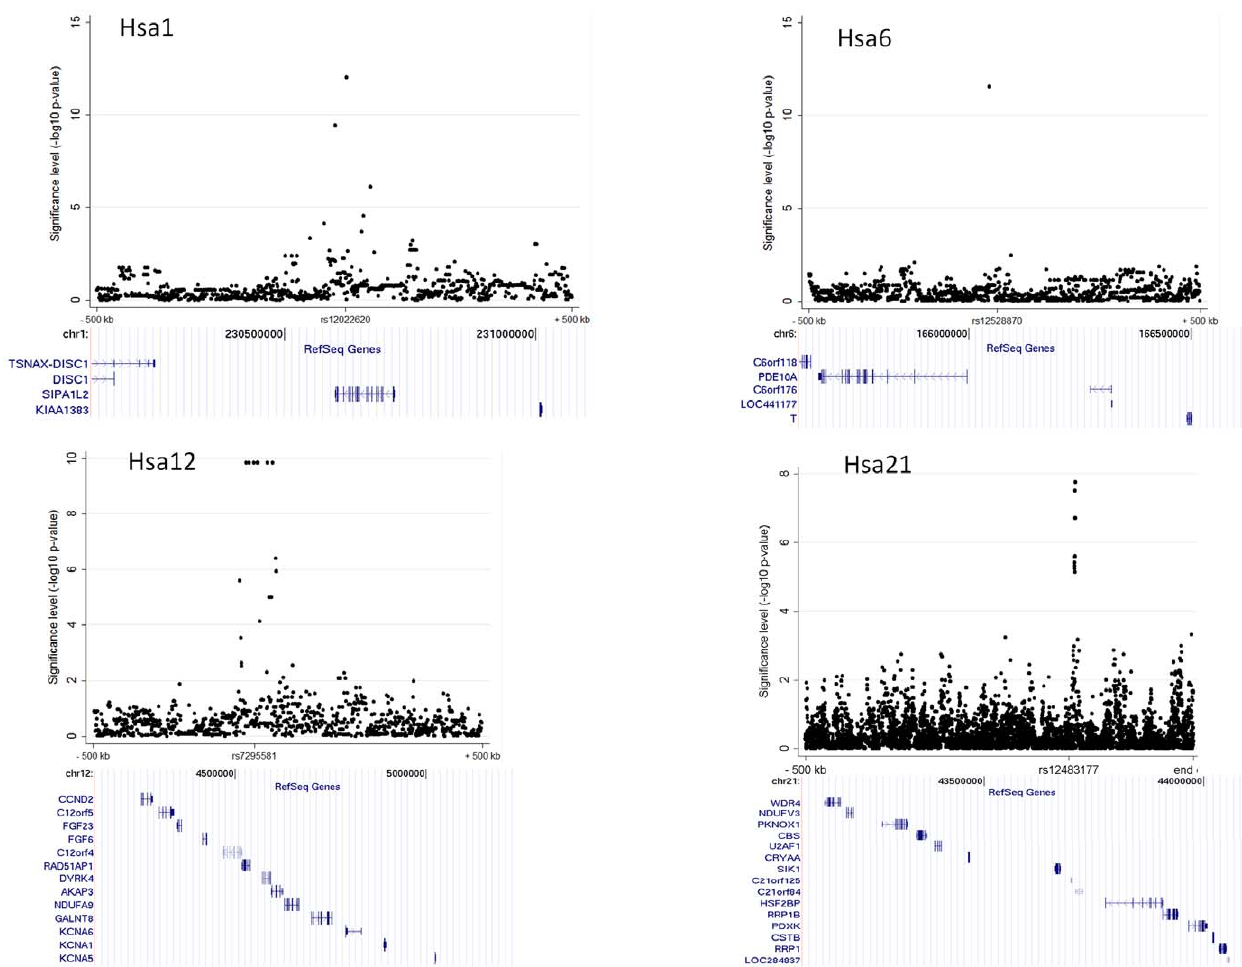
Figure 5. Examples of significant association findings in HapMap GWA. The significance level ( 2 log 10 P) of the top two association findings and two examples of top hits overlapping with either linkage, top GWA in KORA-GenCord, overlap with known candidate genes, or top findings on Hsa21 are shown within a genetic region of 1 Mb (( 6 500 kb around the significantly associated SNP). The chromosome, SNP ID, location and genic context (RefSeq genes, using UCSC genome browser) are indicated for each depicted